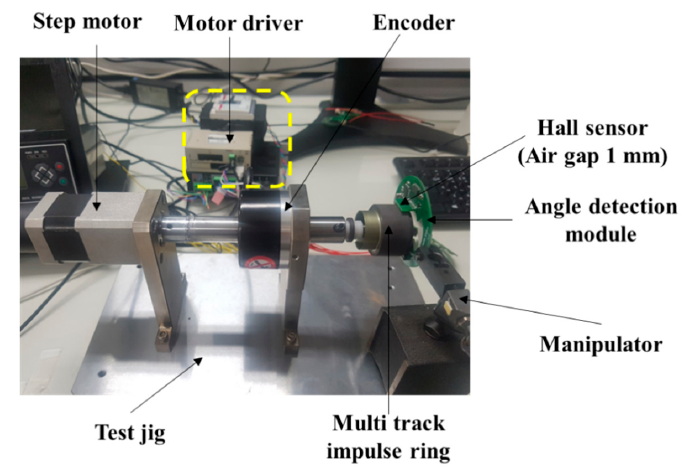
Figure 7. Test stand and experimental setup.